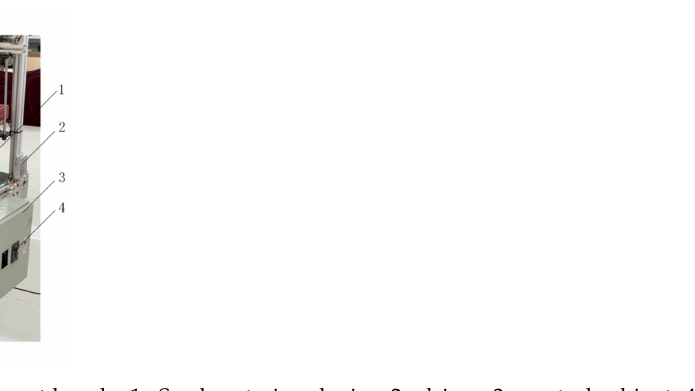
Figure 6. The experiment bench. 1. Seed-metering device, 2. driver, 3. control cabinet, 4. knob, 5. speed control motor, 6. conveyor belt, 7. image acquisition device, 8. drive motor, and 9. bench.